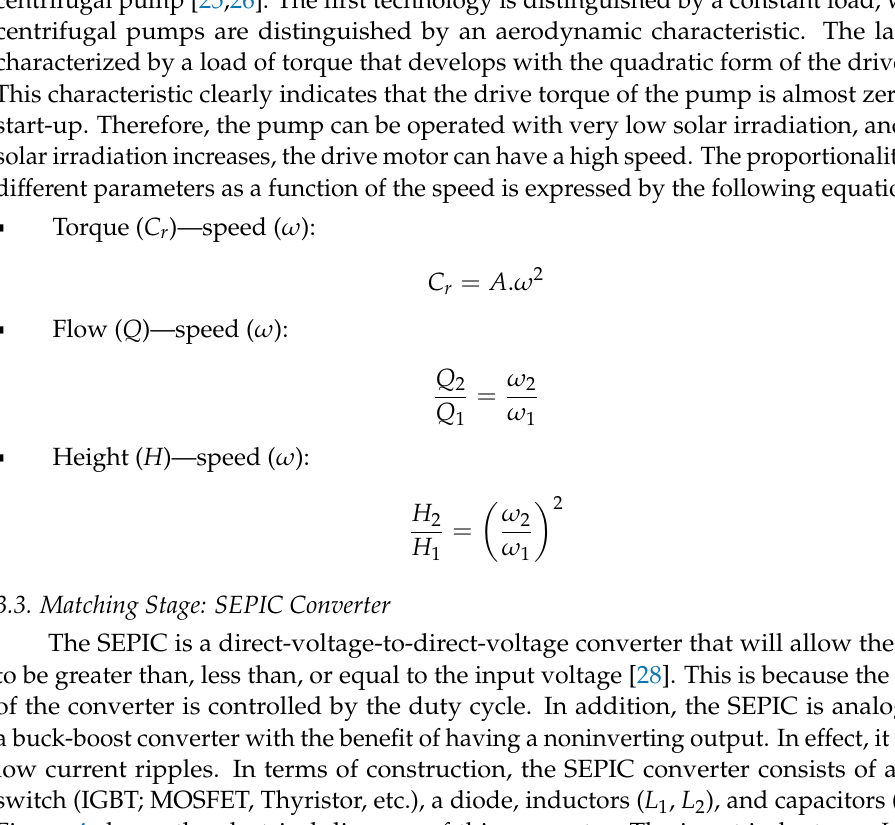
Figure 4. Electrical diagram of a SEPIC converter [28].